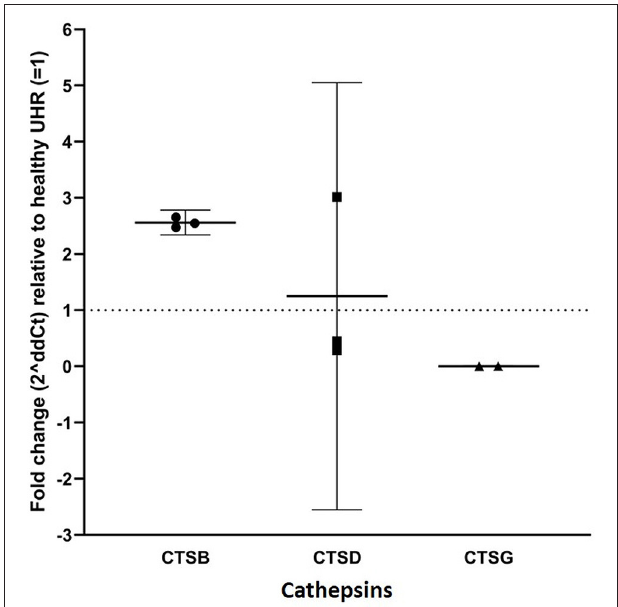
FIGURE 3 | RT-qPCR on three arterio-venous malformation-derived primary cell lines. Cathepsin B (CTSB), cathepsin D (CTSD) and cathepsin G (CTSG) are shown on the X-axis. Expression was normalized to reference genes GAPDH and PUM1 and fold-change was calculated relative to healthy universal human reference (UHR), as indicated by the Y-axis. There was a 2.5-fold-change in expression of cathepsin B, an insignificant 1.25-fold change in cathepsin D expression, and significantly downregulated expression of cathepsin G, relative to UHR.